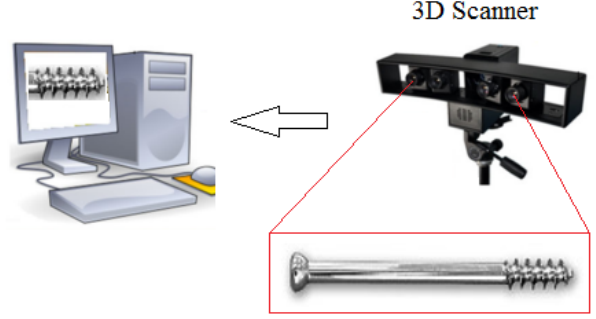
Figure 2. The scanning of screw using a 3-D scanner.